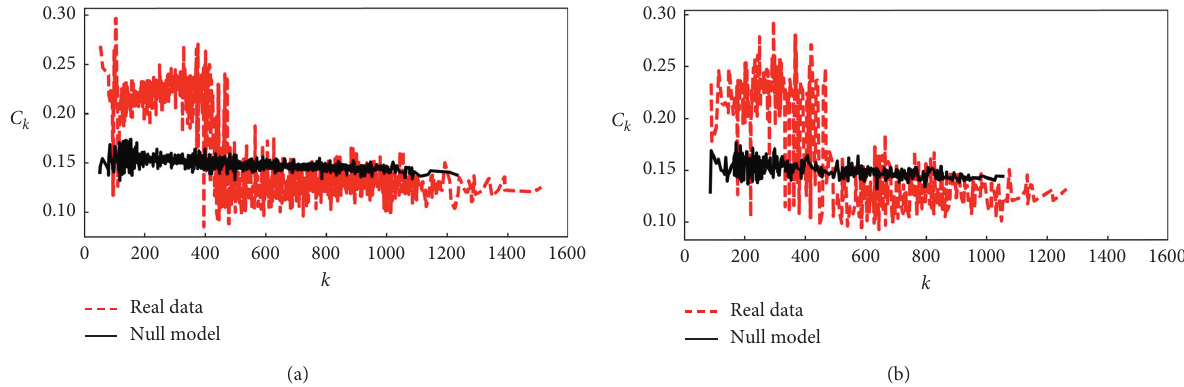
Figure 2: Clustering for (a) real-world network and (b) null model network.